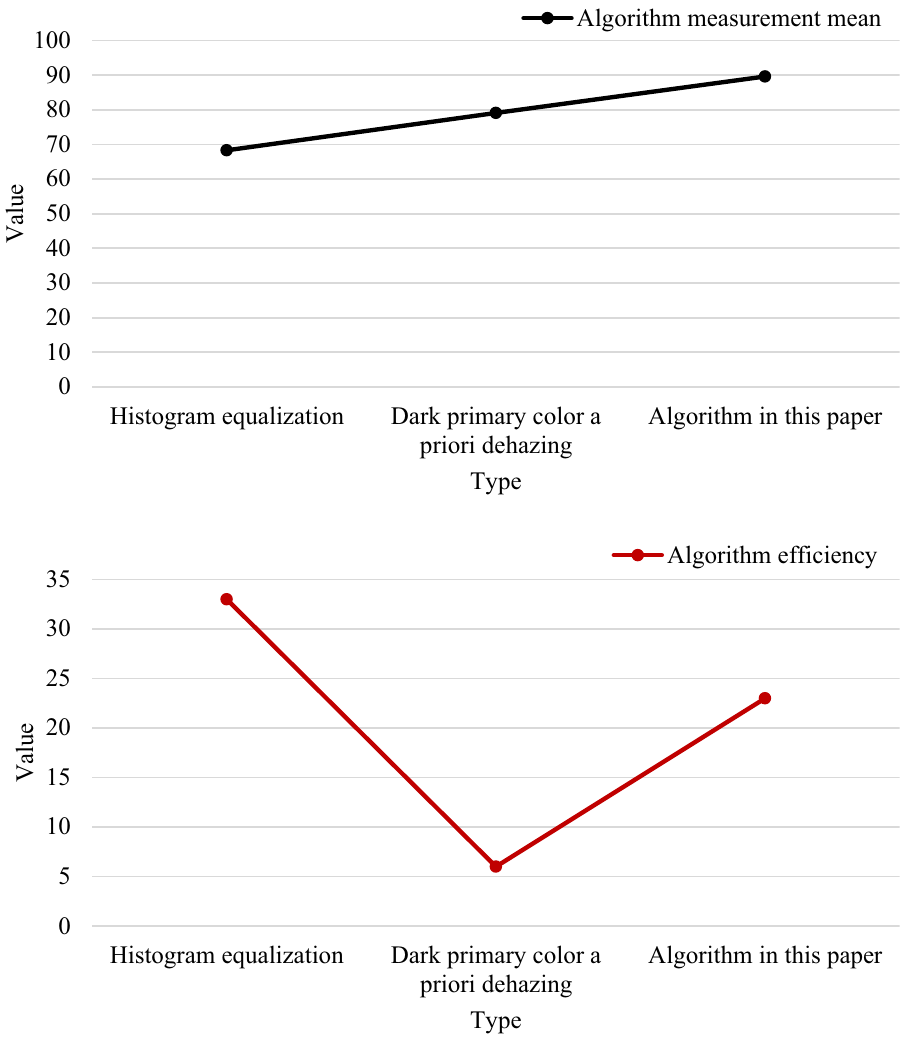
Figure 10. Comparison of the results of three target